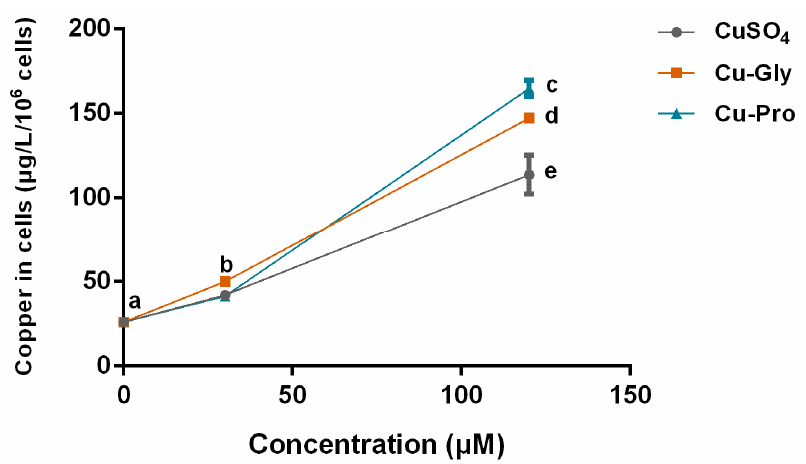
7 of 18 Figure 1. Cell viability in response to different copper concentrations for 10 h. ( a ) Cell counting kit 8 (CCK-8) cell viability assay. ( b ) EdU staining assay. ( c ) Statistical analysis of the percentage of EdU positive cells. The result was represented as a percentage of the control. Data represent mean values ± standard deviation ( n = 4). Significant differences between processing groups are represented by different lowercase letters ( p < 0.05). 3.2. Copper Uptake in Cells Since the bioavailability of the inorganic and organic copper sources may lead to different uptake rates, the intracellular copper levels were measured by ICP-MS. After exposing IPEC-J2 to